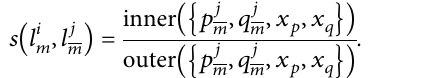
Figure 5: The hypothesis of the three-dimensional line segment generated by the two-dimensional potential matching line segment.